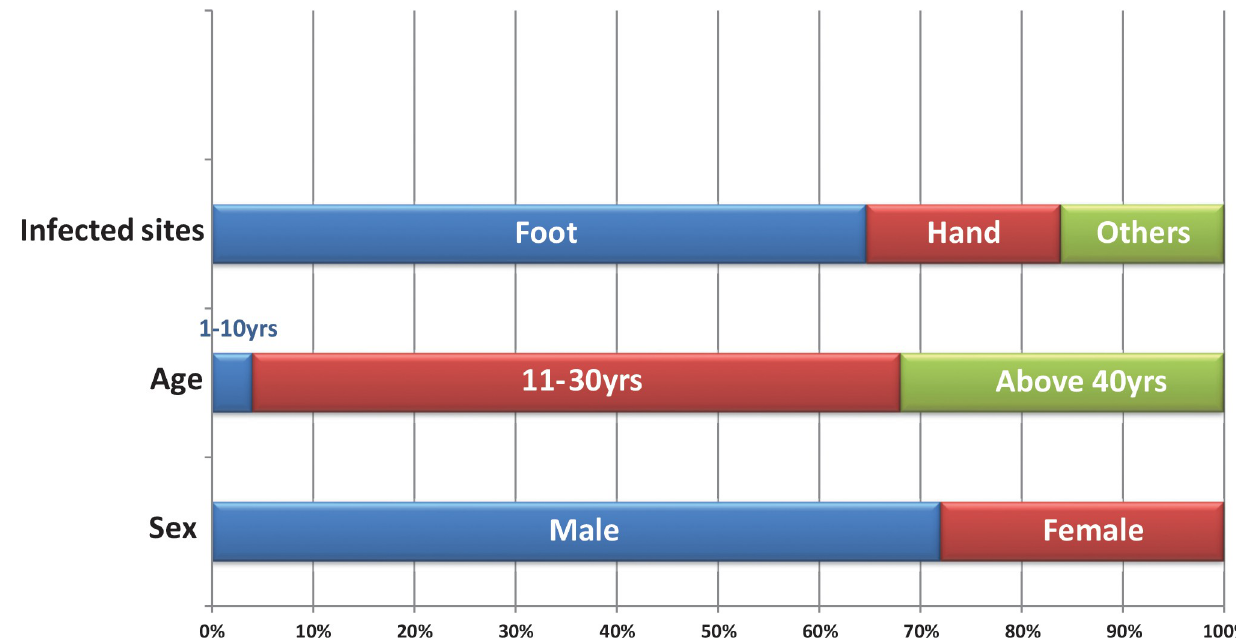
Fig 2. Frequency of sex, age groups and infected body sites among studied mycetoma patients .